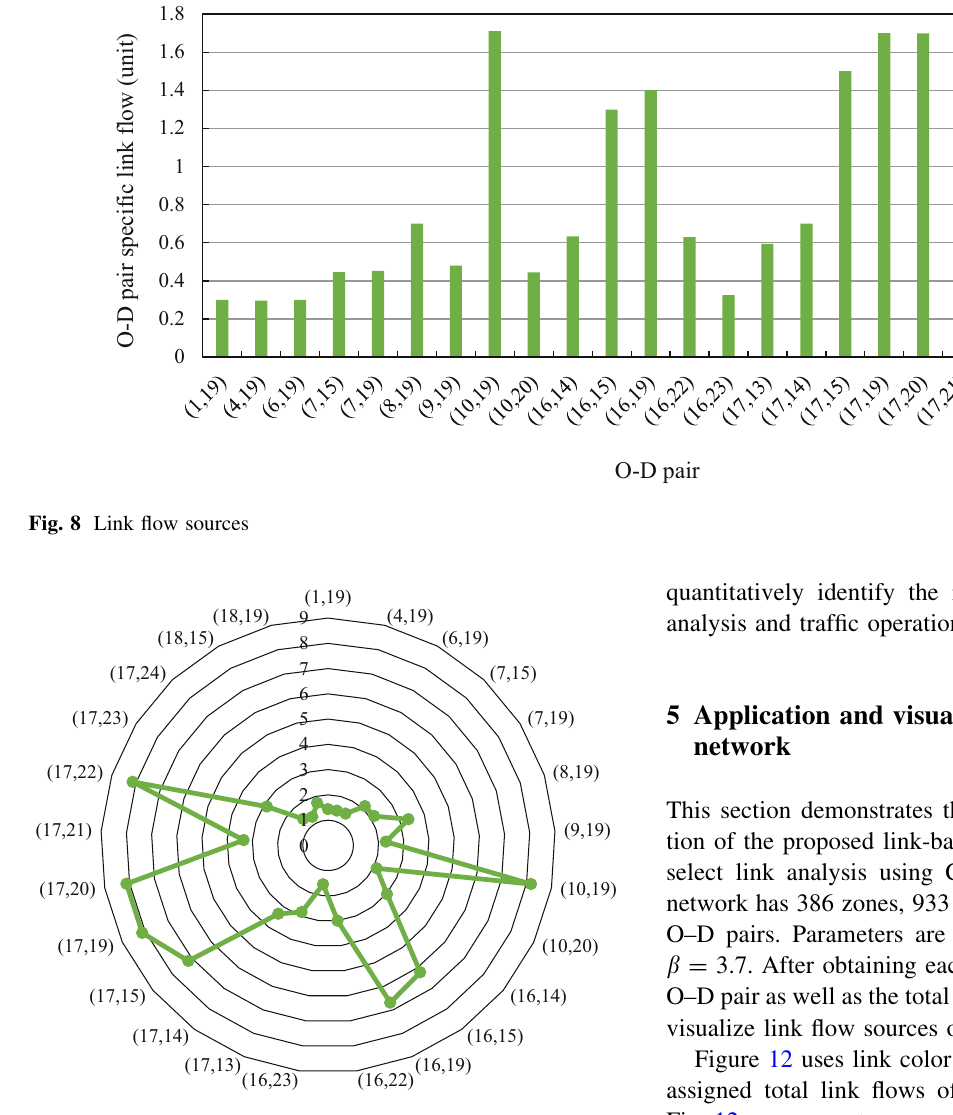
Fig. 9 Link flow sources percentage